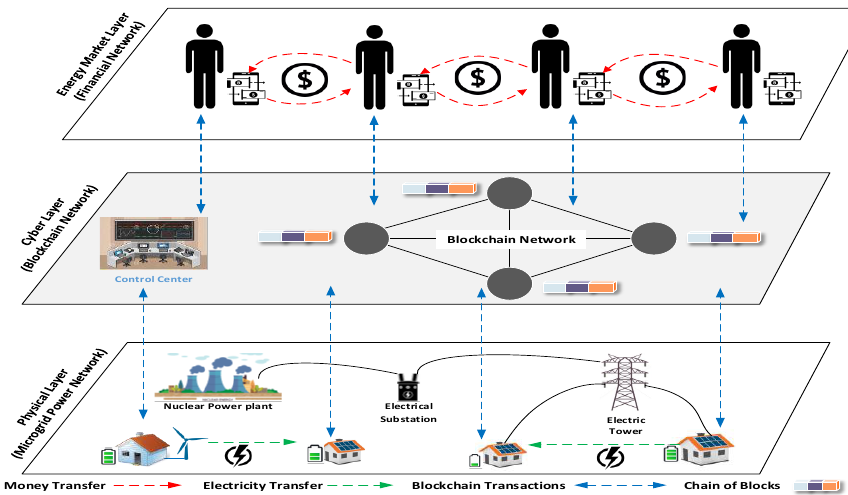
Figure 1. High level architecture of energy transaction in blockchain-enabled